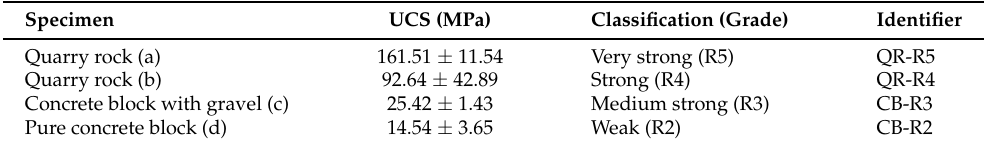
Table 5. Laboratory results of UCS for testing